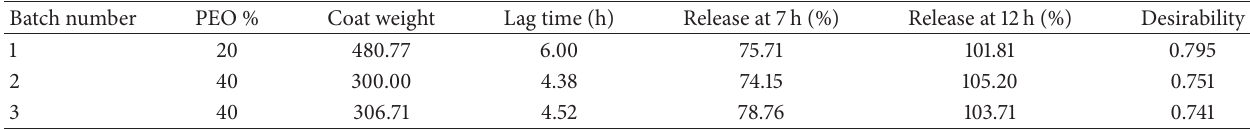
Table 5: Solutions that meet the criteria required for floating pulsatile release